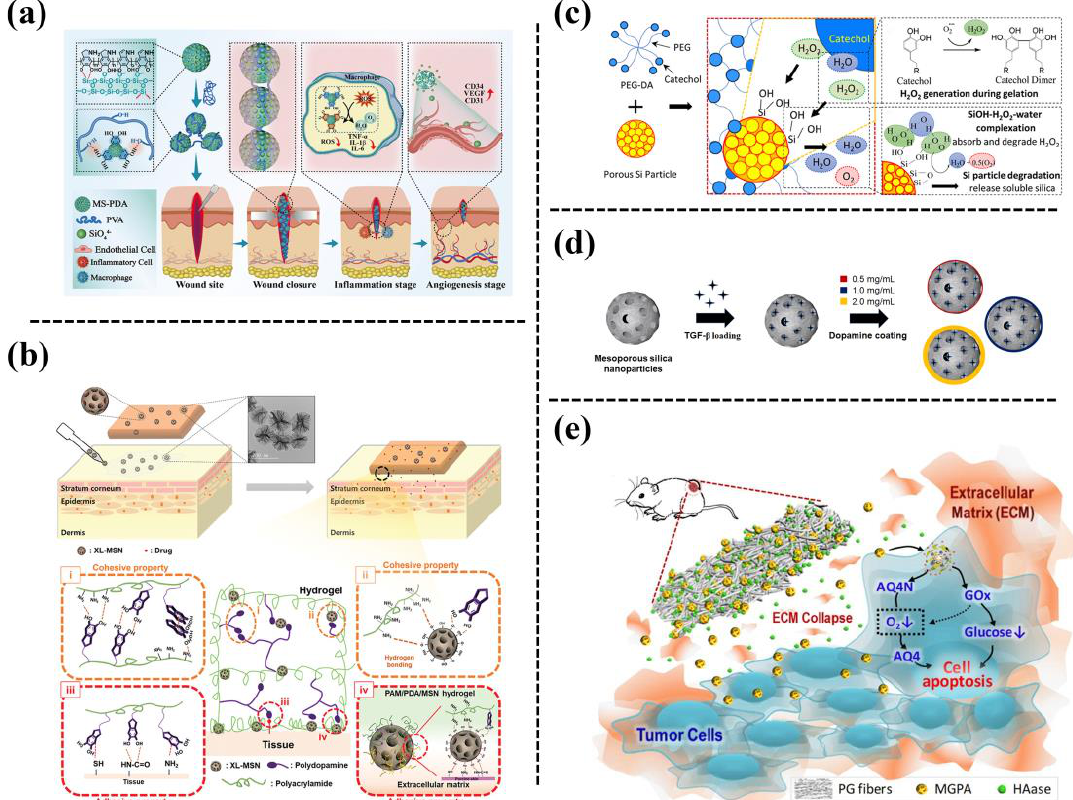
Figure 3. ( a ) Schematic of preparing a PVA entangled porous nanoadhesive system of PDA/silica with an ROS scavenging/angiogenesis ability for efficient skin wound closure [53]. ( b ) Schematic of adhesive hydrogel patch consisting of PAM/PDA hydrogels embedded with extra-large pore mesoporous silica nanoparticles (XL-MSNs) [54]. ( c ) Fabrication of a catechol-containing polyethylene glycol-based adhesive (PEG-DA) formulated with silica NPs to control the released amount of H 2 O 2 [55]. ( d ) Fabrication of PDA-coated mesoporous silica NPs that can be stably incorporated within macroporous μRB scaffolds to allow the tunable release of transforming growth factor (TGF- β3) [56]. ( e ) Schematic illustration of combination therapy based on hierarchical PGH@MGPA composite fibers [57].